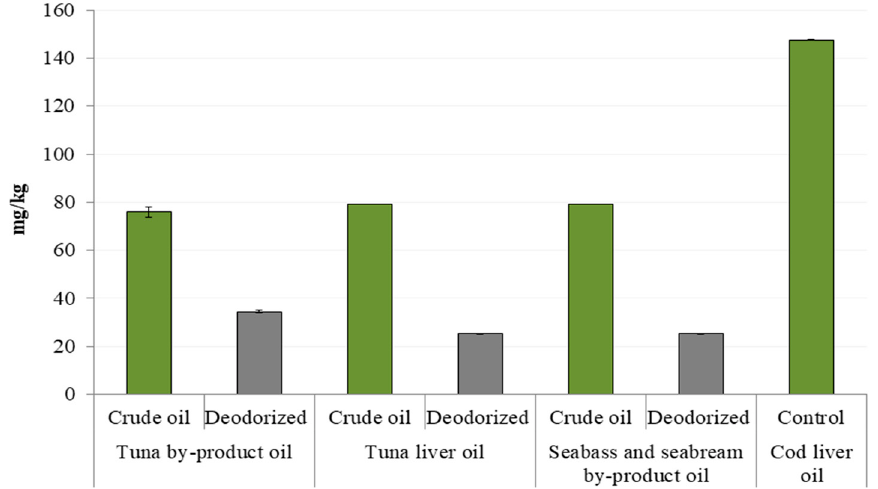
Figure 3. The tocopherol content ( n = 12) in crude and deodorized (refined) oils from tuna by-products, tuna liver, seabass and gilthead seabream by-products and cod liver oil (control).